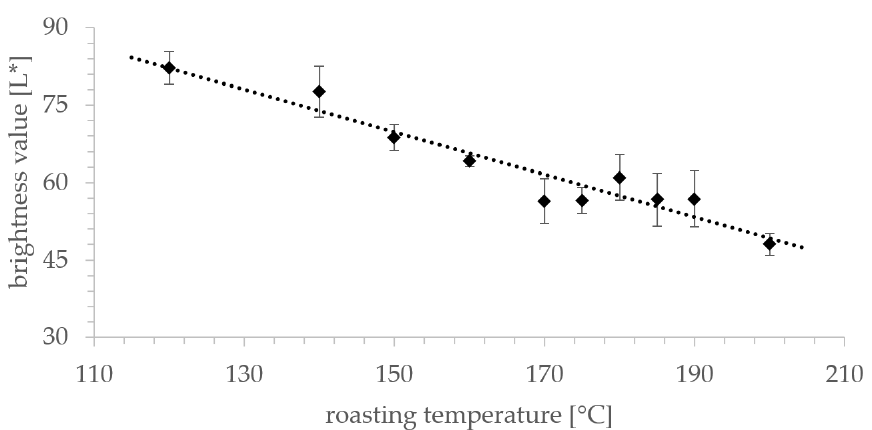
Figure 7. Brightness values (L *) of roasted rye; samples ( n = 5) were measured with an X-rite VeriColor spectro spectrophotometer. Roasting duration: 20 min.